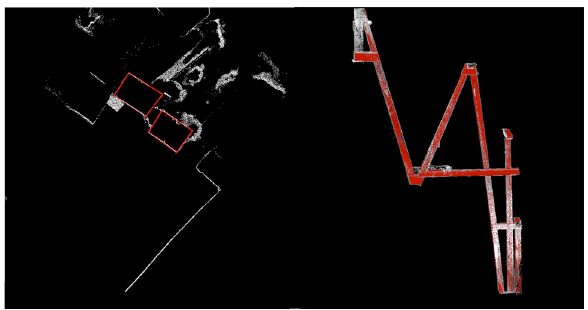
Figure 8. Generation of solids from laser data sections.